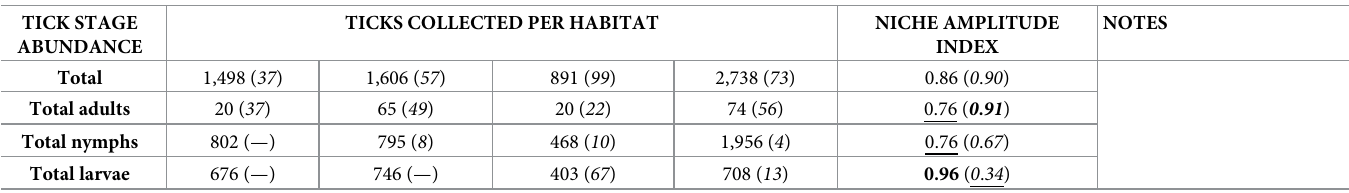
and an average of 24˚C. The average solar radiation captured in the dry season in the habitat of Star Grass Paddock was 2.5 times higher than in the Cocoa Crop and more than 17 times higher than in the Ripar- ian Forest. In the same sense, the average solar radiation measured in the Cocoa Crop in the wet season was 1.8 times higher than the King grass recorded values, while the litter had an average 1.35 times higher in relative humidity than the Cocoa Crop habitat. Therefore, the cli- matic and microclimatic data show that, within the Matepantano farm, A . mixtum may live in an environment with significant variations in a single day and between seasons.